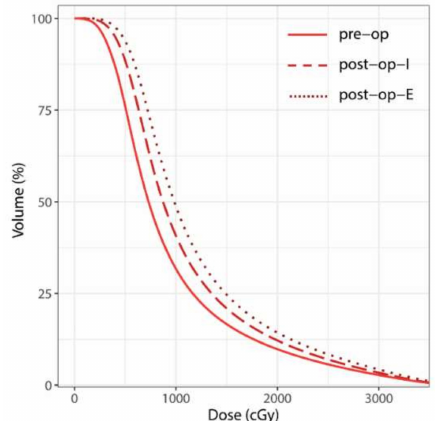
Figure 4. Mean cumulative dose-volume histogram (DVH) curves over all patients for the healthy brain (HB) surrounding the pre-operative and post-operative planning target volumes (PTVs), respectively (= surrounding HB minus respective PTV). Abbreviations: Pre-op: pre-operative; post-op-I: post-operative involved field (cavity + 3 mm); and post-op-E: post-operative extended field (including surgical